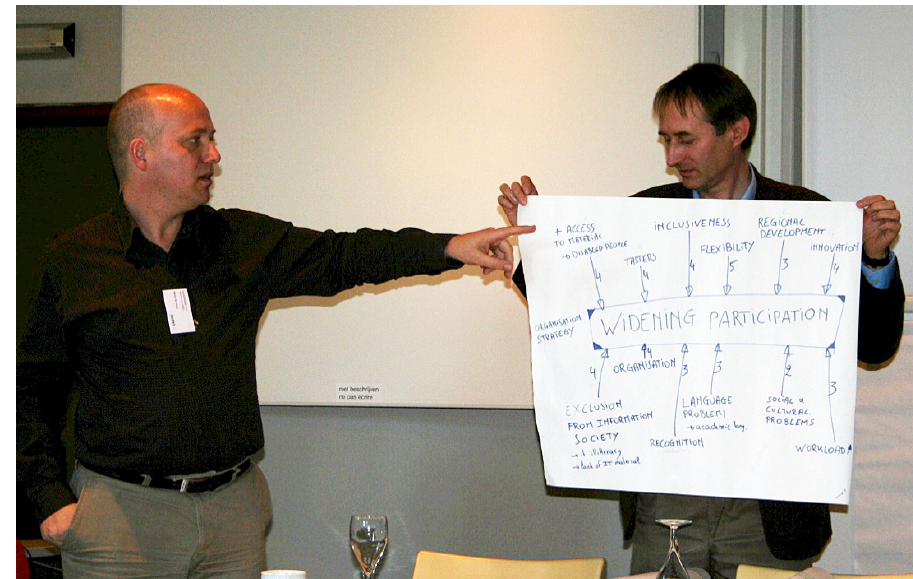
Figure 2 . A MORIL workshop force field diagram.